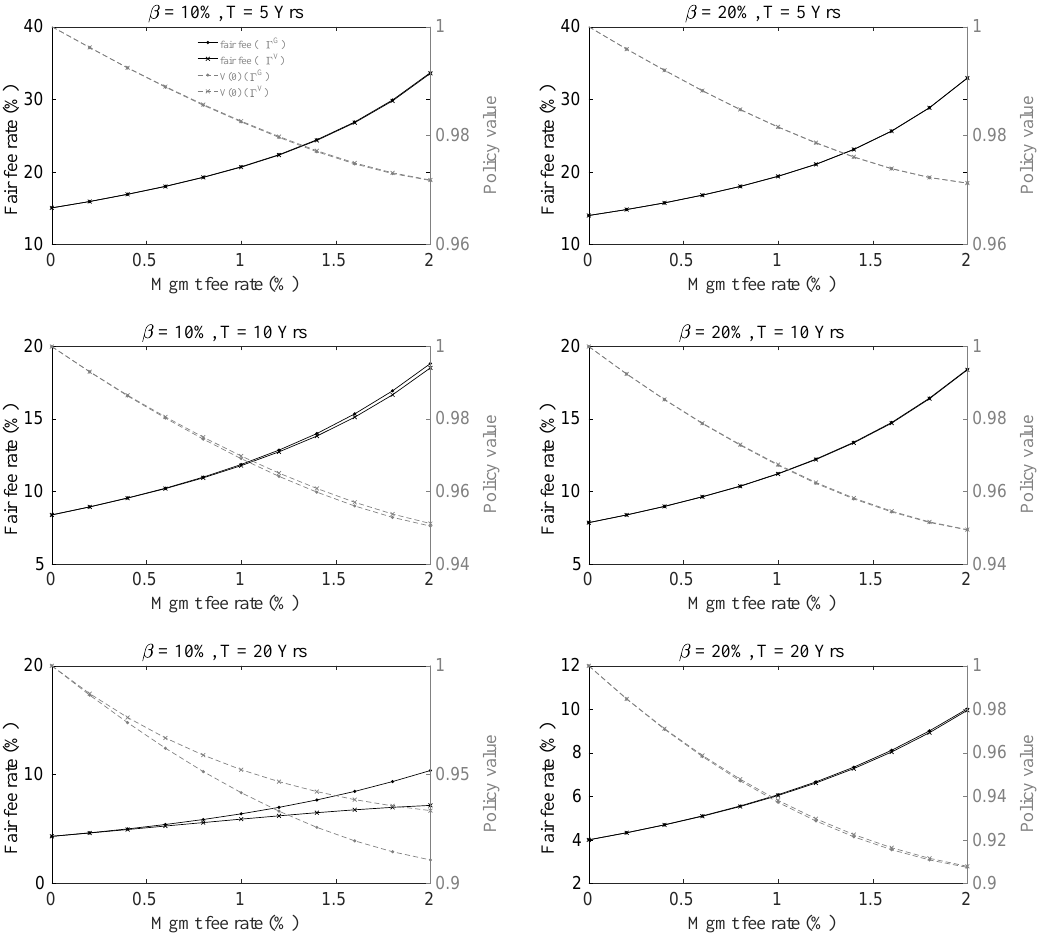
Figure 3. Fair insurance fee rates and policy values as a function of management fee rates α m for risk-free rate r = 1% and volatility σ = 30%, for penalty rates β = 10%,20% and maturities T = 5,10,20 years. The left axis and dark plots refer to the fair fees in percentage; the right axis and gray plots refer to the policy values. Legends across all plots are shown in the upper left